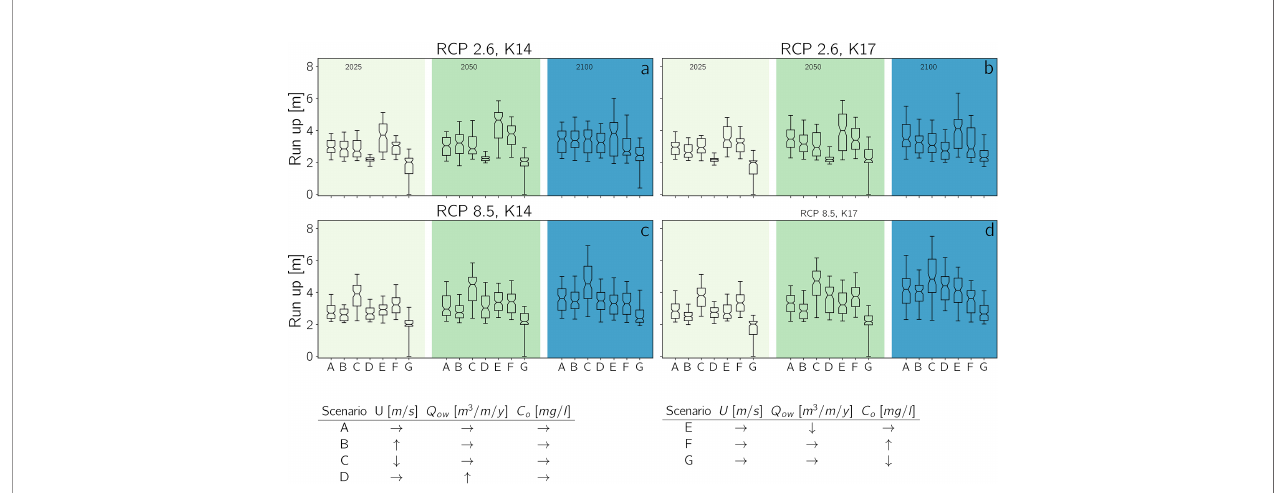
FIGURE 6 | Run-up distributions for the different climate change scenarios for a M w 8.9 for RCP 2.6 K14 (A) and K17 (B) , and RCP 8.5 K14 (C) and K17 (D) . The different climate-change scenarios are of combinations of wind speed ( U ), overwash sediment fl ux ( Q ow ), and sediment concentration in the open ocean ( C o ) are given below. The range for ↑ (increasing) and ↓ (decreasing) varies between 5 – 15 m/s for wind speed, 5 – 300 m 3 /m/y for overwash sediment fl ux and 0.001 – 0.3 mg/l for the open ocean sediment concentration The values for ! are U = 10 m/s , Q OW = 100 m 3 /m/y , and C O = 0.1 mg/l